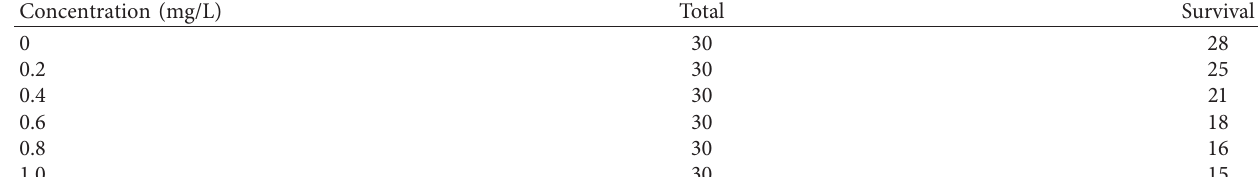
Table 1: Effects of carbendazim on LC